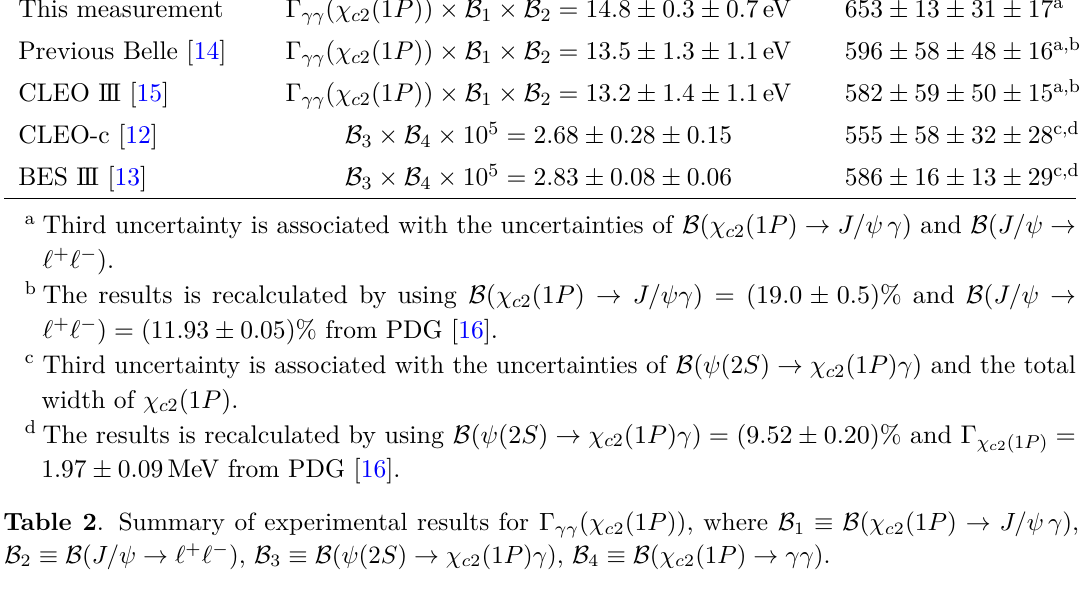
Table 2 . Summary of experimental results for Γ γγ ( χ c 2 (1 P )) , where B 1 ≡ B ( χ c 2 (1 P ) → J/ψ γ ) ,